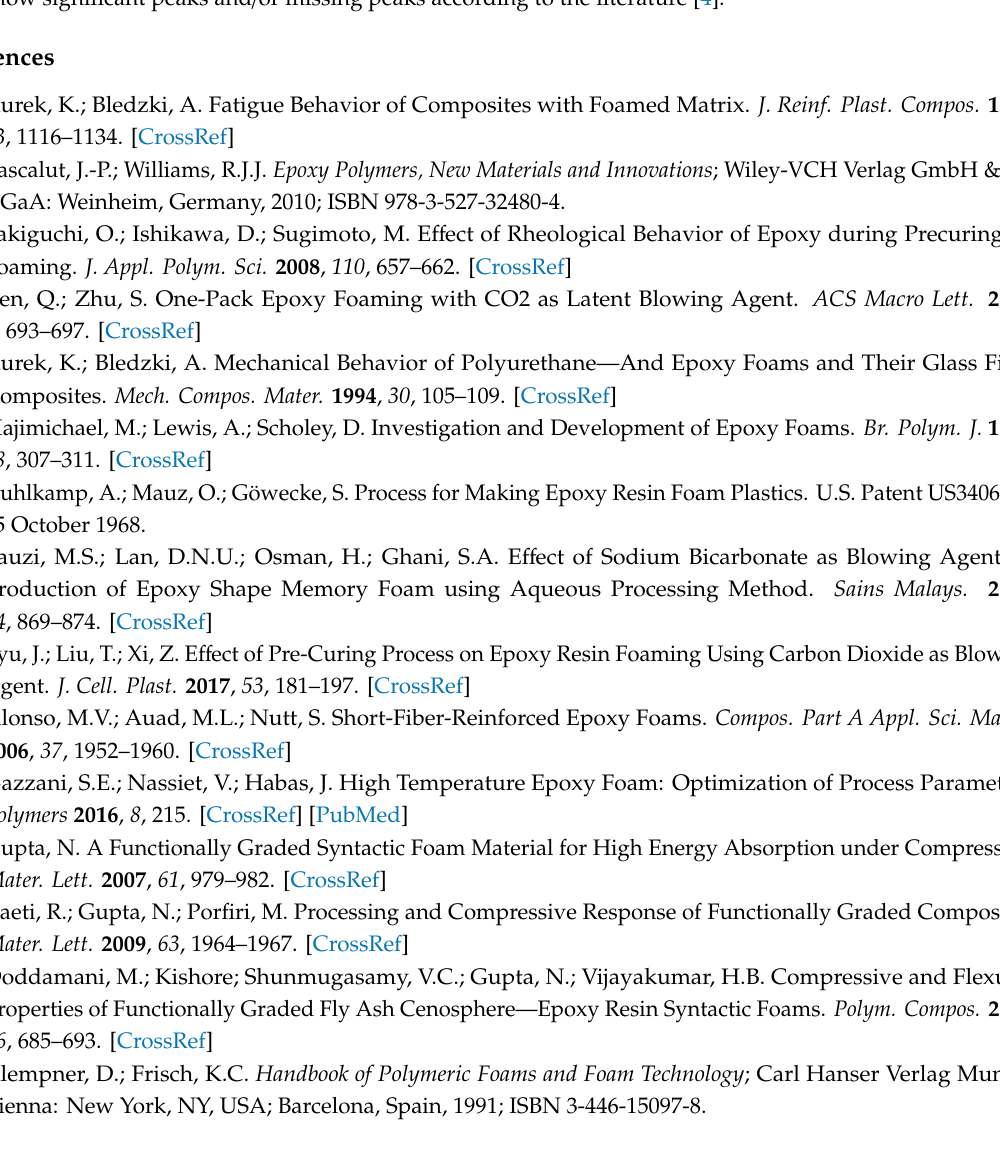
Figure A2. Fourier transform infrared (FTIR) spectra of AEP and B-AEP; the lines and wave numbers show significant peaks and/or missing peaks according to the literature [4].